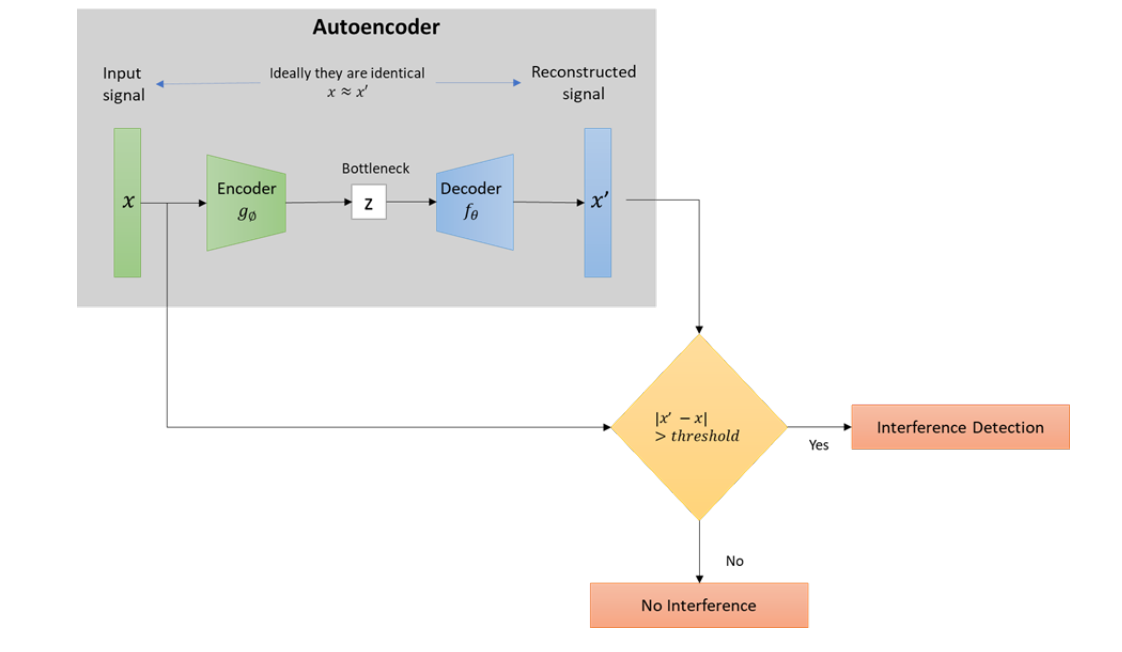
Figure 3. Autoencoder for interference